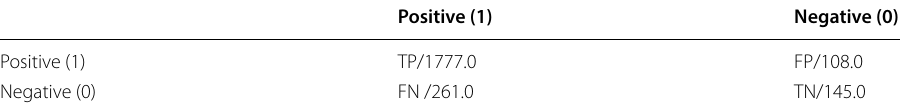
Table 13 Confusion matrix for multilayer perceptron